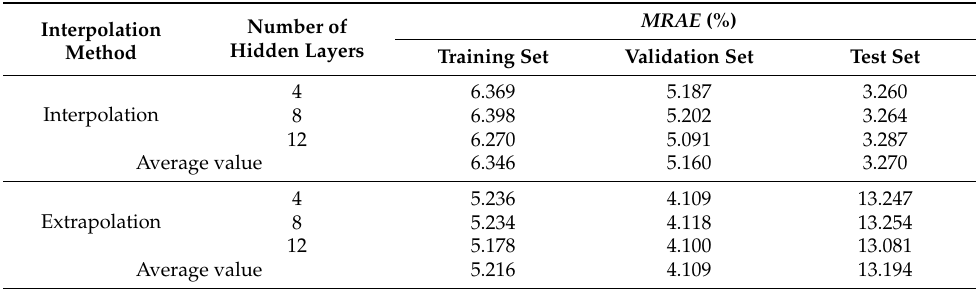
Table 9. The prediction results of model resistance coefficient C t using backpropagation neural network